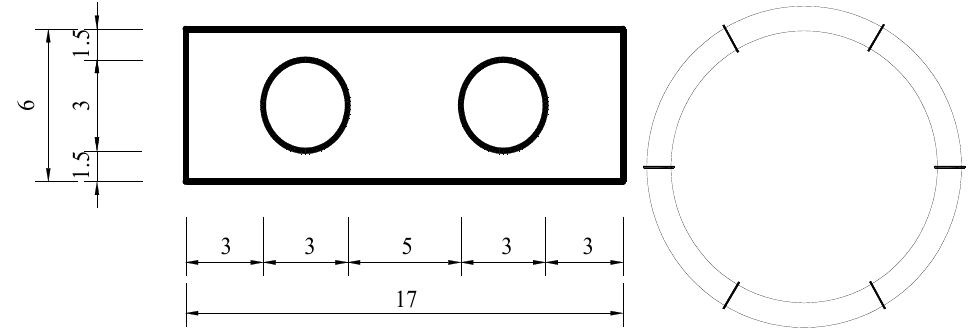
Figure 1. Size of joint piece and connection of segments.